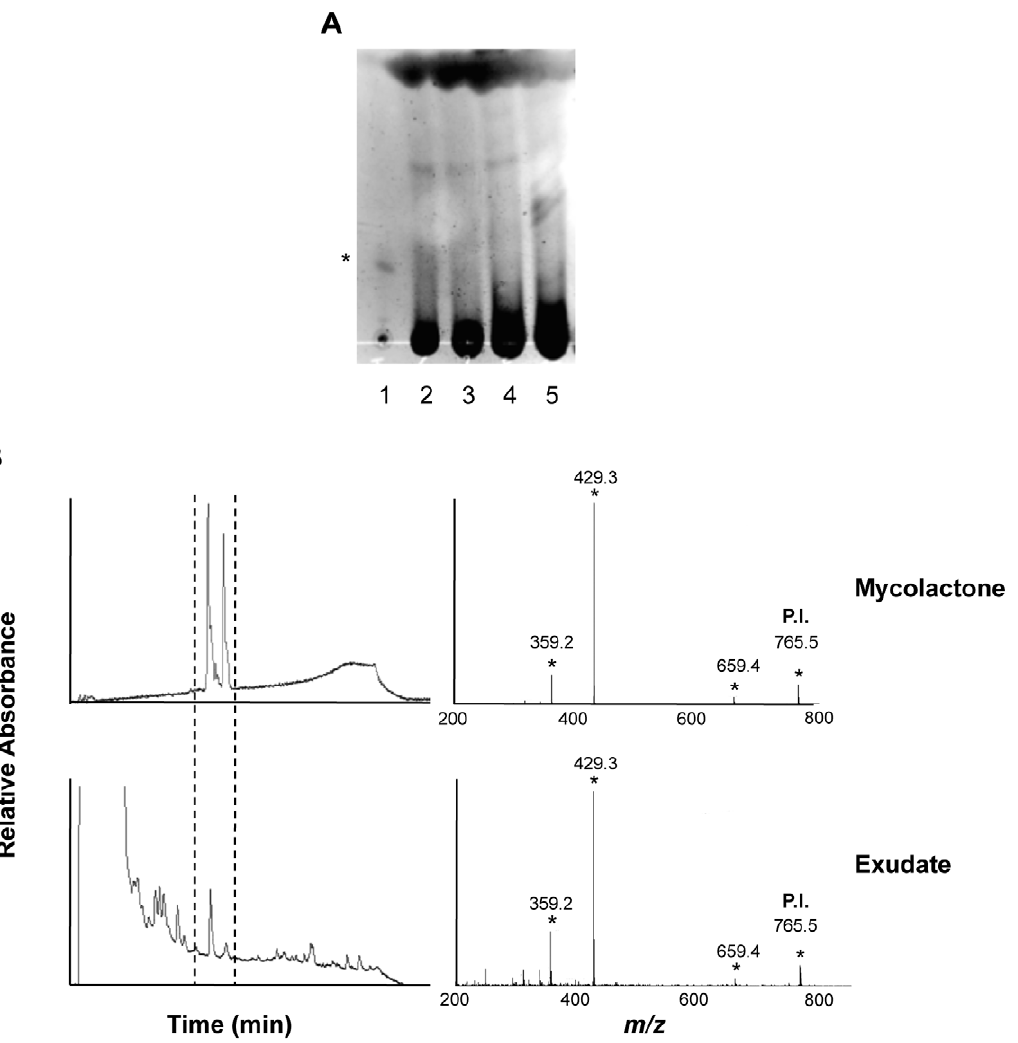
Figure 2. Structurally intact mycolactone is detected in ulcer exudates of BU patients. (A) Example of the fluorescence signals given by ulcer exudates (lanes 2–5), compared to pure mycolactone (lane 1) following analysis by TLC-Fluo. The band corresponding to mycolactone is designated by an asterisk. (B) HPLC elution profiles are shown for reference mycolactone (100 ng) and for one representative ulcer exudate among the 20 positive ones. The corresponding MS/MS spectra are presented, with mycolactone parent ion (P.I.) and products designated by asterisks. Similar MS/MS spectra were obtained from HPLC elution peaks collected from three positive patients.